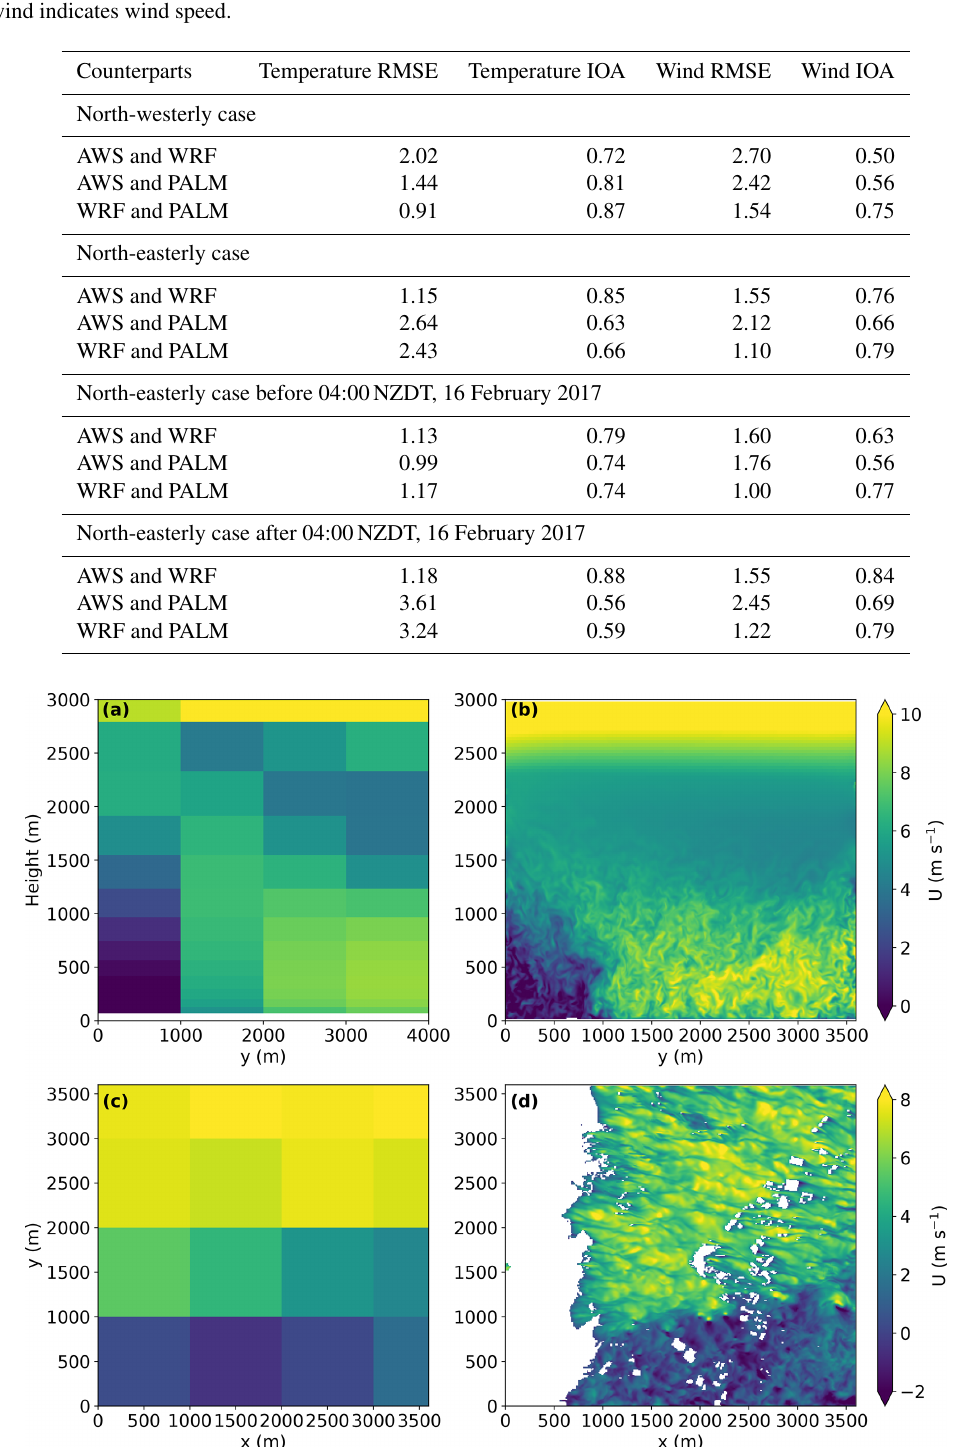
Table 4. Comparison of RMSE and IOA between the AWS observational data, the WRF modelling data, and the PALM modelling data at surface. Here, wind indicates wind speed.